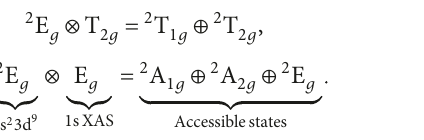
Figure 6: Multielectronic term scheme for 3d 9 Cu 2+ comparing the 1s2p RIXS and direct 2p XAS pathways. Where SOC S = 1/2 → ⊗ E included, the spin multiplicity is